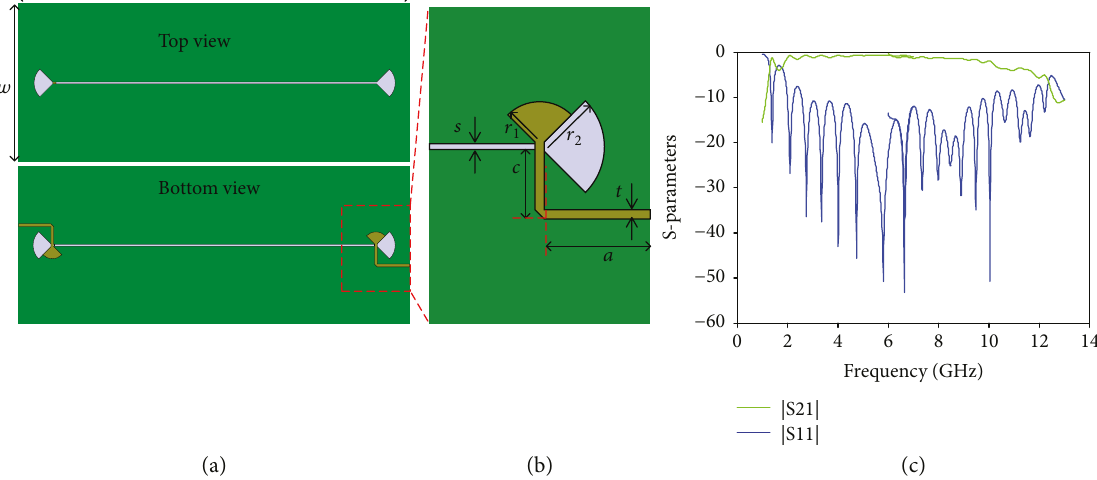
Figure 2: (a) Top and bottom views of the microstrip-to-slotline transition, (b) zoomed in plot for the detail of the transition part with parameter de fi nition, and (c) the numerical simulation results for the wideband transition in the frequency range of 2 – 13